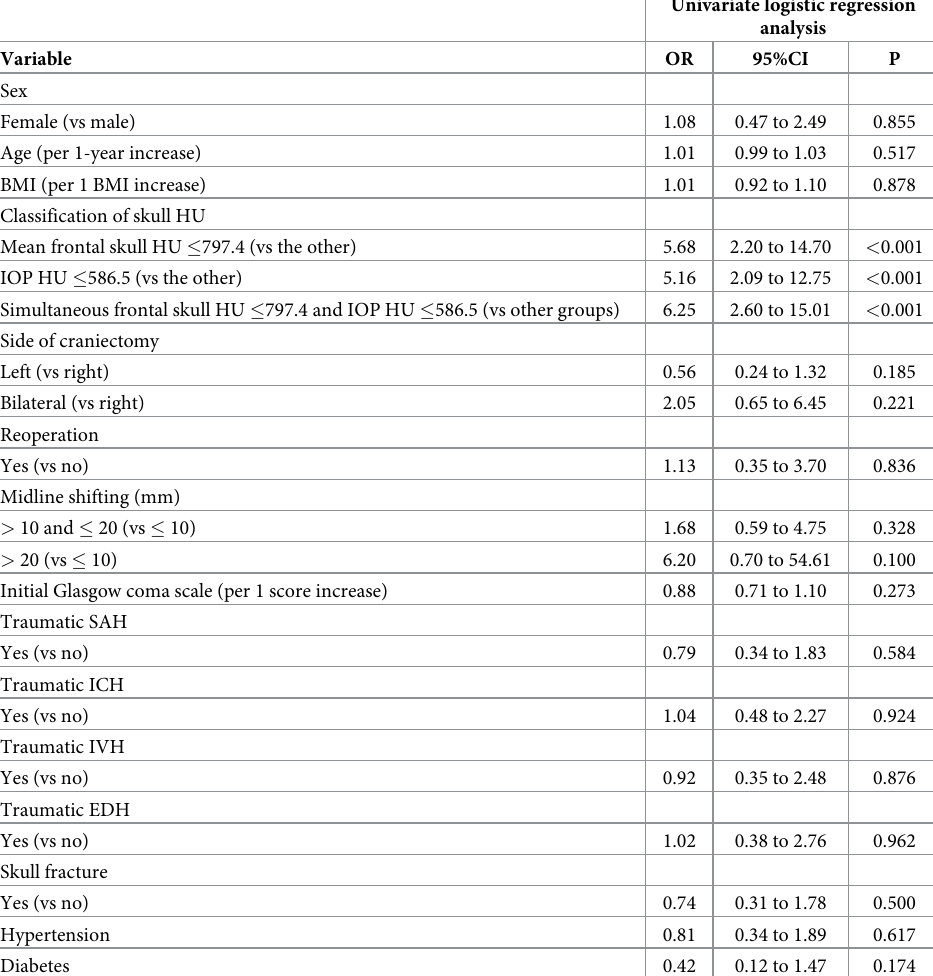
Table 3. Univariate logistic regression analysis of shunt-dependent hydrocephalus in patients ultimately receiving cranioplasty after craniectomy due to traumatic subdural hematoma based on various predictive factors.